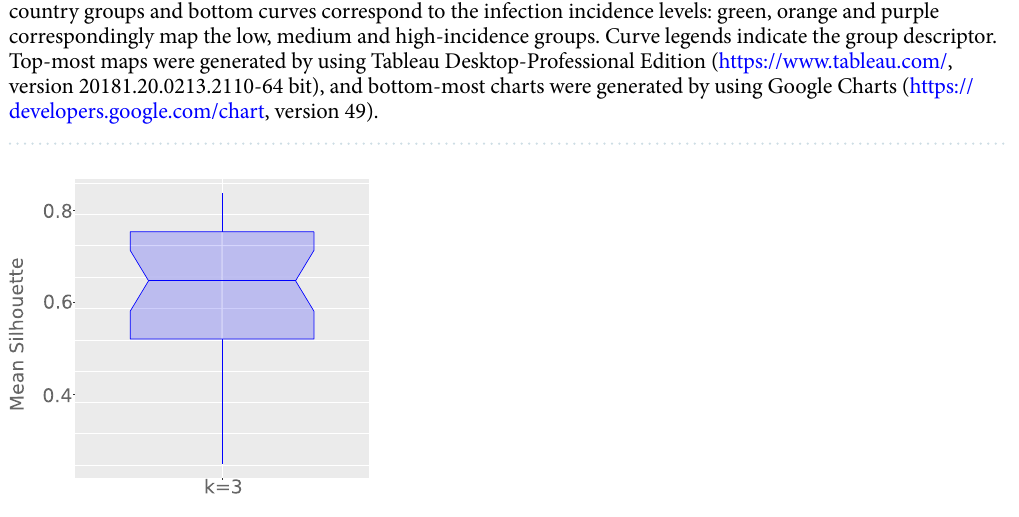
Figure 5. Mean Silhouette ( S µ ) variation by considering three groups of countries clustered by the absolute number of death per million